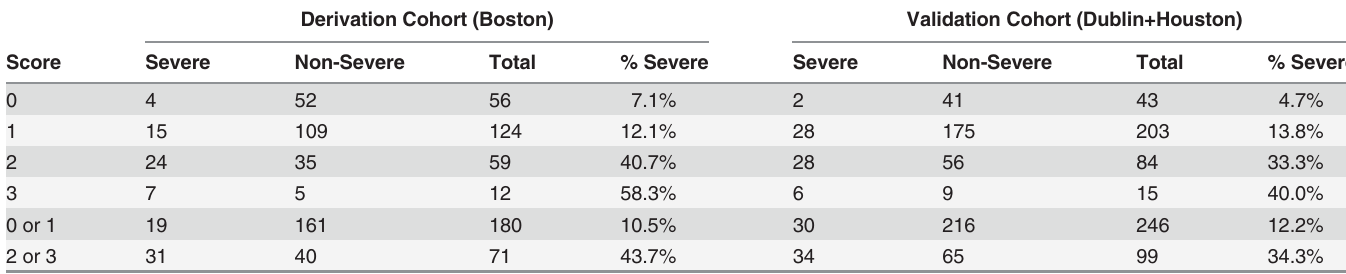
Table 4. Risk of severe outcomes of C . difficile infection according to Prediction Score 1 . Derivation Cohort